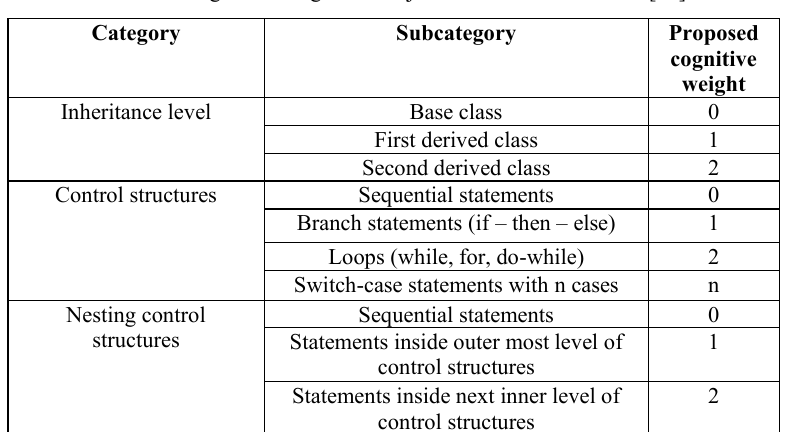
Table 2. Cognitive weights for object-oriented source codes